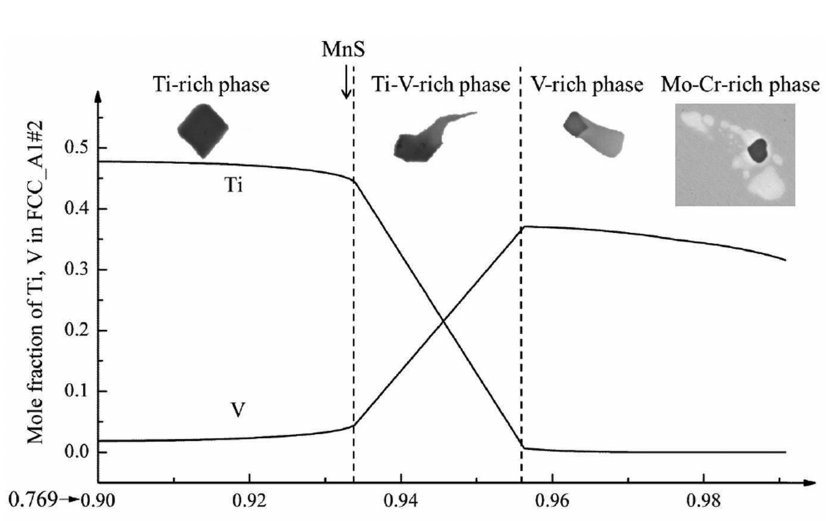
Figure 8: The generating process of the large phases during